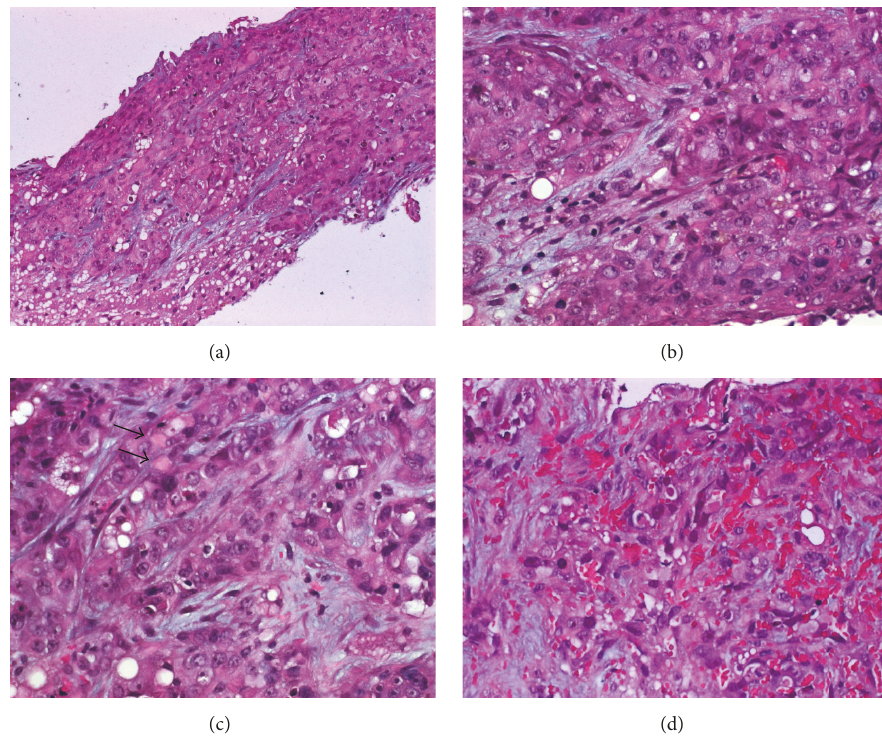
Figure 2: (a) Liver biopsy showed tumor tissue diffusely infiltrating the liver parenchyma (normal liver is seen in lower left field). (b) Higher magnification showed anaplastic large epithelioid cells with prominent nucleoli. (c) Scattered rhabdoid inclusions are seen (arrows) as well as small cytoplasmic vacuoles possibly suggestive of abortive glandular differentiation. (d) In other areas, hemorrhage and spindling might be mistaken for a vascular